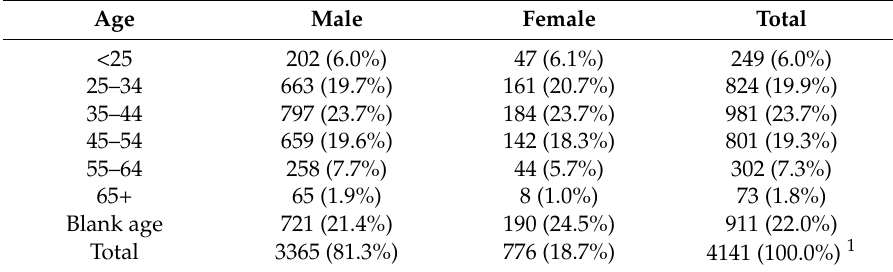
Table 2. Bicycle rider summary within the TxDOT El Paso